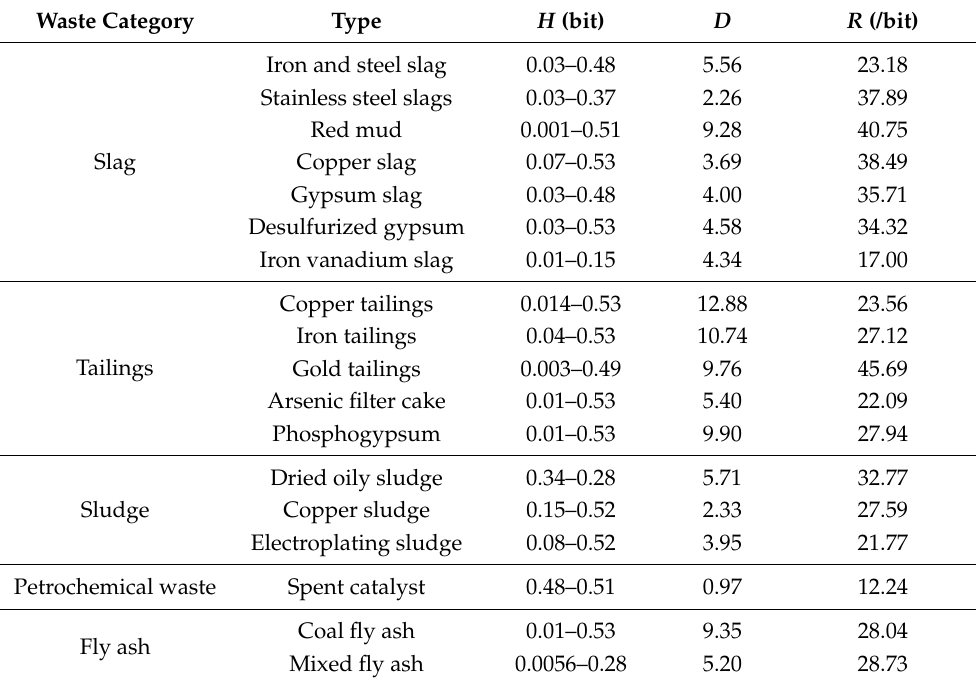
Table 3. Entropy, grade, and recyclability of industrial waste